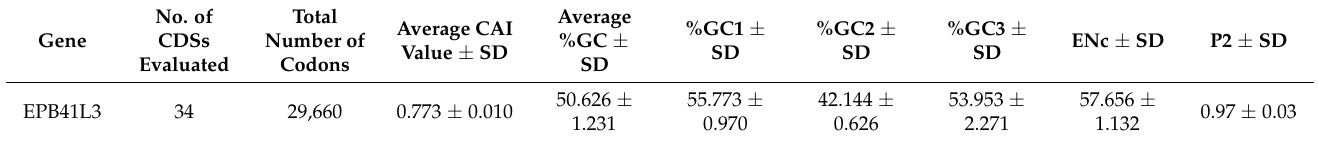
Table 2. Total codons count for all the 34 transcripts of the EPB41L3 gene with the average values of CAI, GC%, GC1%, GC2%, GC3%, ENc, and